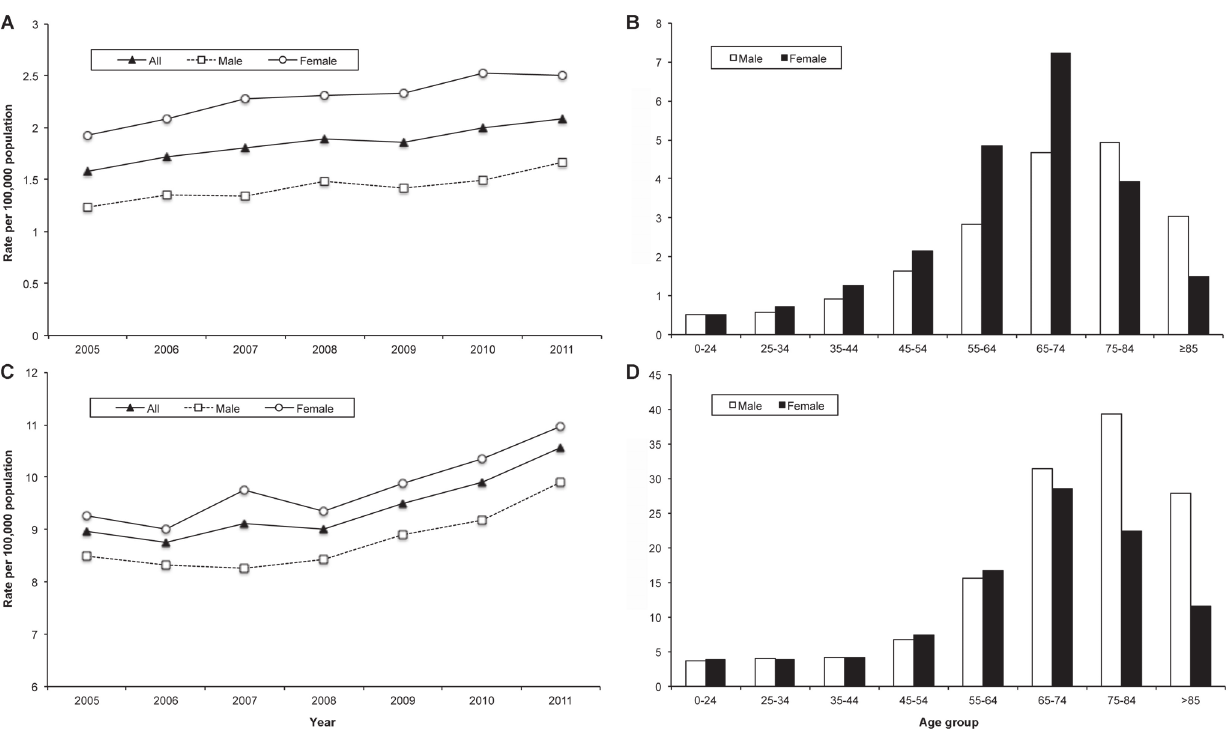
Figure 2. Annual age-adjusted and average annual age-specific hospitalization rates. (A) Annual age-adjusted hospitalization rate and (B) average annual age-specific hospitalization rate of bronchiectasis as the primary hospital discharge diagnosis by year, age group and sex, respectively; (C) annual age-adjusted hospitalization rate and (D) average annual age-specific hospitalization rate of bronchiectasis as any diagnoses by year, age group and sex, respectively, Germany, 2005–2011.